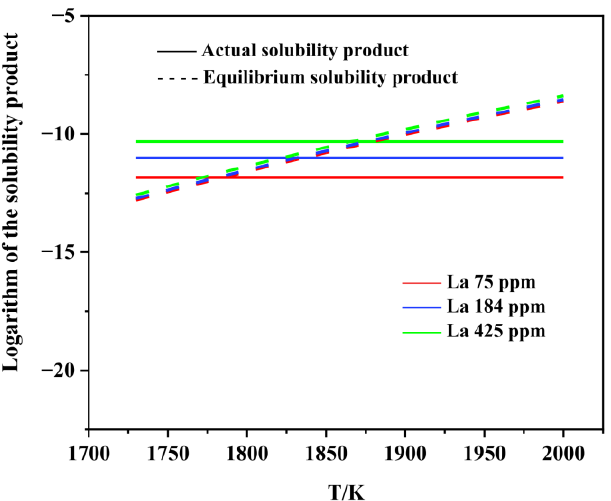
Figure 12. Logarithm of the solubility product as a function of temperature for LaS in liquid steel.